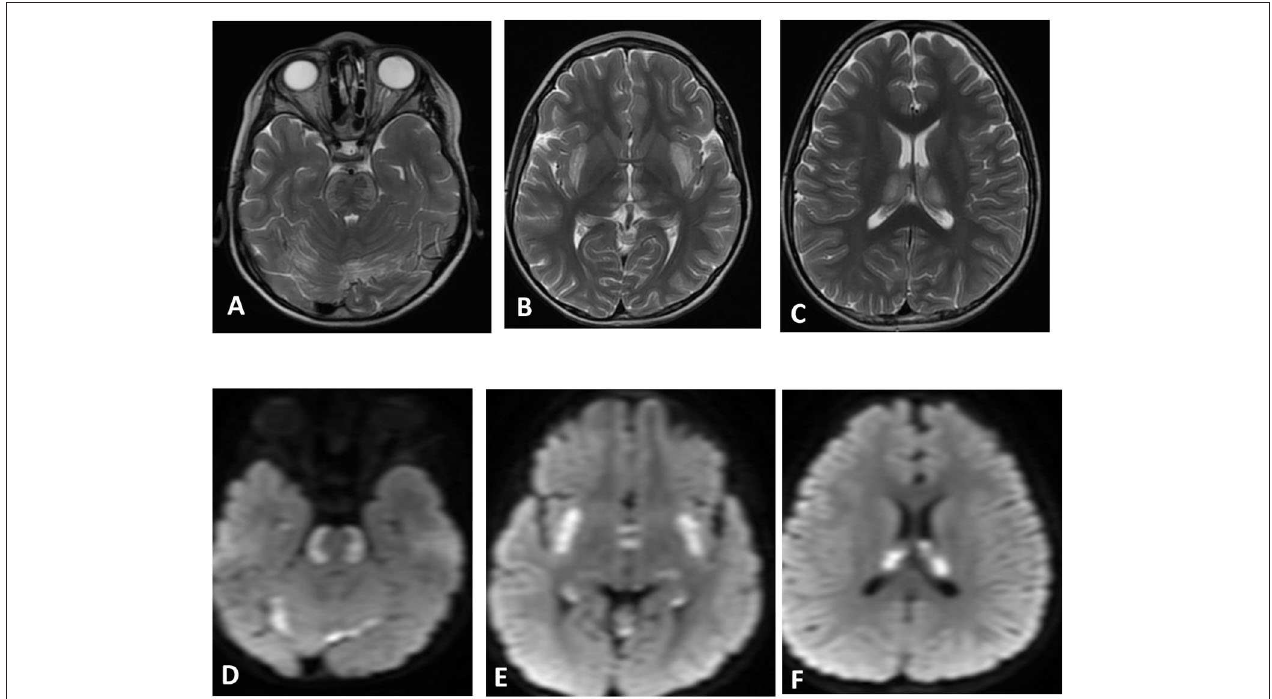
FIGURE 3 | Brain MRI. Axial T2 (A–C) and diffusion (D–F) showing swelling and abnormal high signal intensity of pons, bilateral external capsule, and subinsular cortex, as well as both thalami with diffusion restriction.